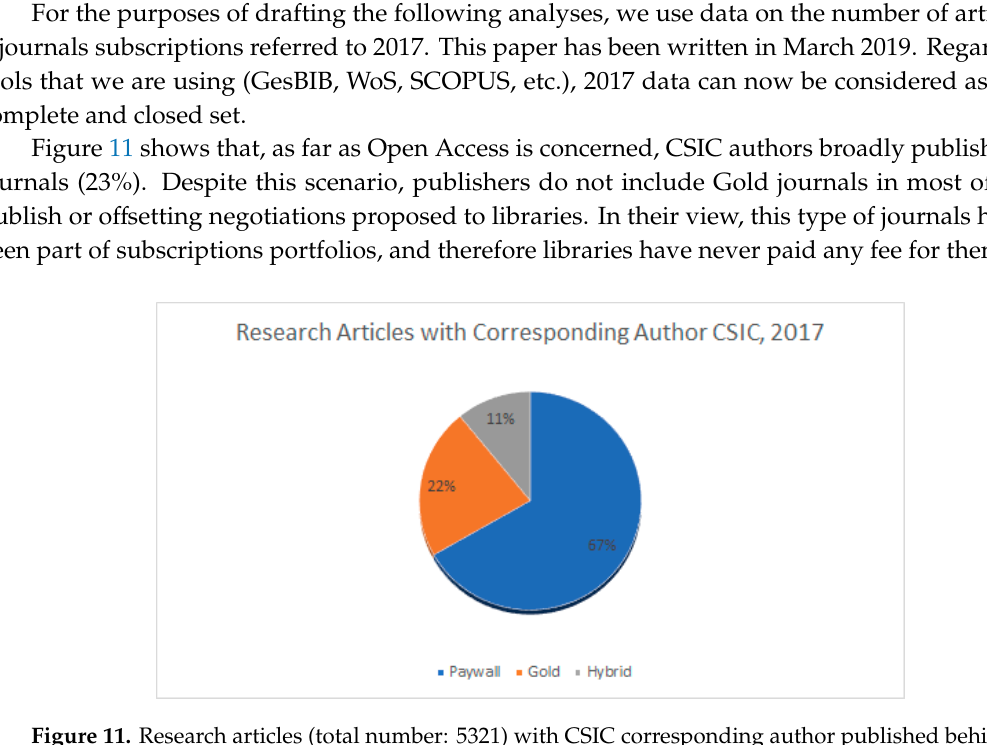
Figure 11. Research articles (total number: 5321) with CSIC corresponding author published behind a paywall or in Open Access (Hybrid or Gold).